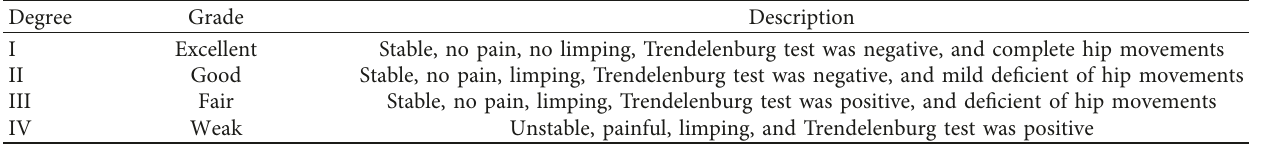
Table 1: McKay’s criteria modified by Berkeley.